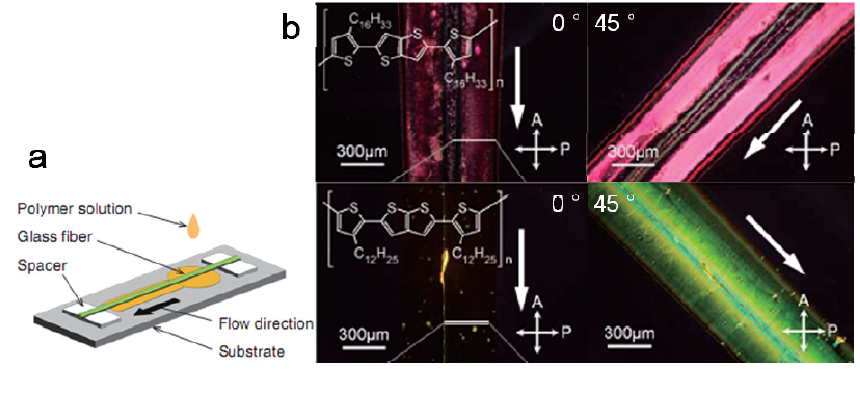
Figure 11. Schematic diagram of polymer film fabrication using capillary action in ( a ) and micrographs of the pBTTT ( upper ) and PBTCT films in cross-polarized light with their molecular structure, the arrows denoting the solution flow direction in ( b ) (Adapted with permission from [120], Copyright Applied Physics Express 2011 The Japan Society of Applied